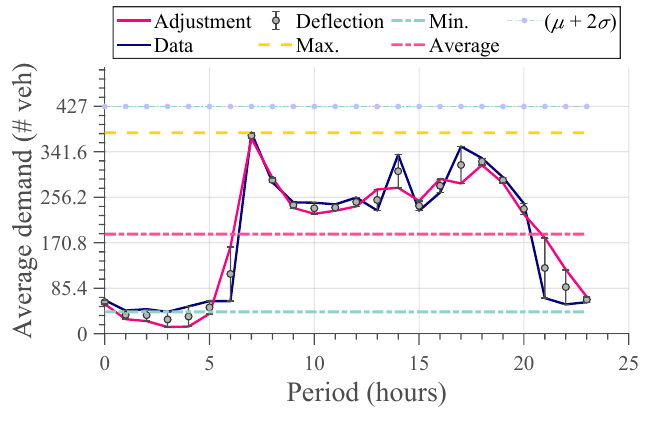
Figure 5. Heterogeneous hourly vehicular demand with VEL = 51.1 km of 13.98 km.